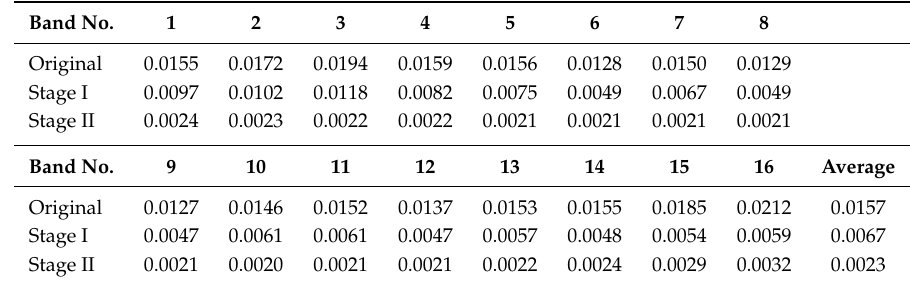
Table 1. Standard deviations computed from all color patches and background samples in the training data. The standard deviations averaged on all bands are also listed.